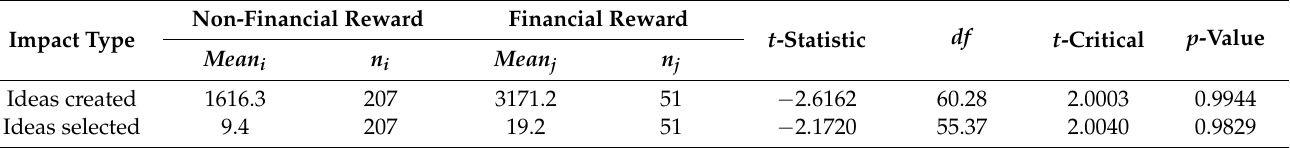
Table 9. Hypothesis test statistics for non-financial and financial rewards